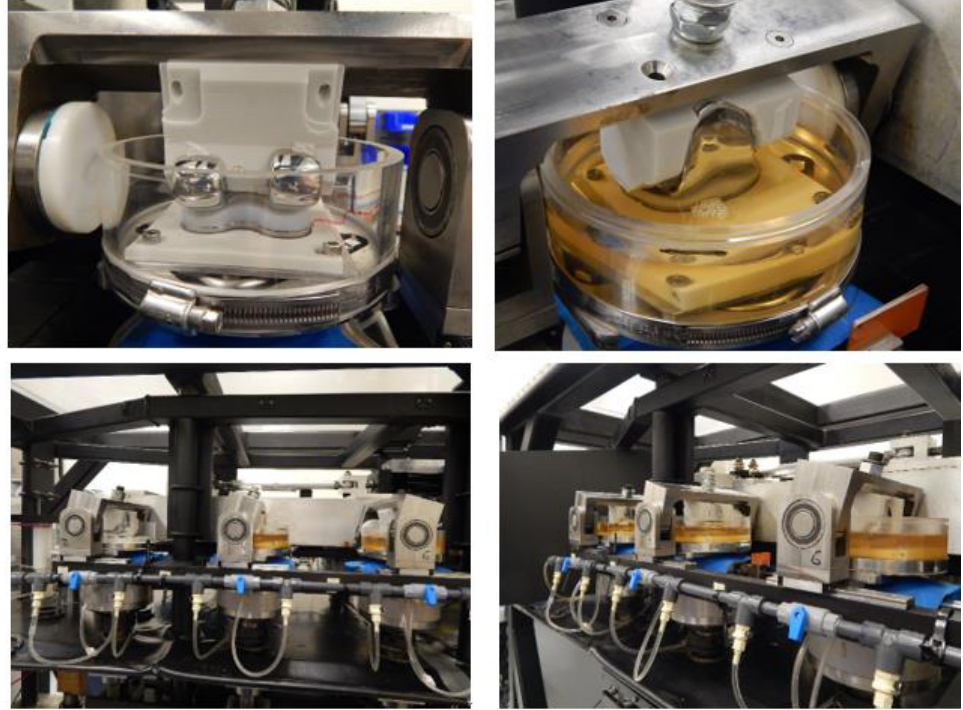
Figure 5. Wear test performed using knee wear simulator with input waveforms; 5 million cycles with a frequency of 1 Hz.